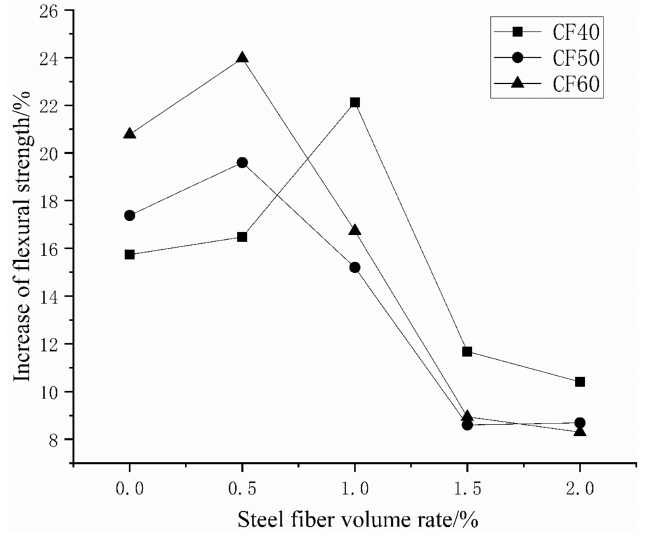
Figure 13. The improvement of the flexural strength of vibrating mixing compared with ordinary